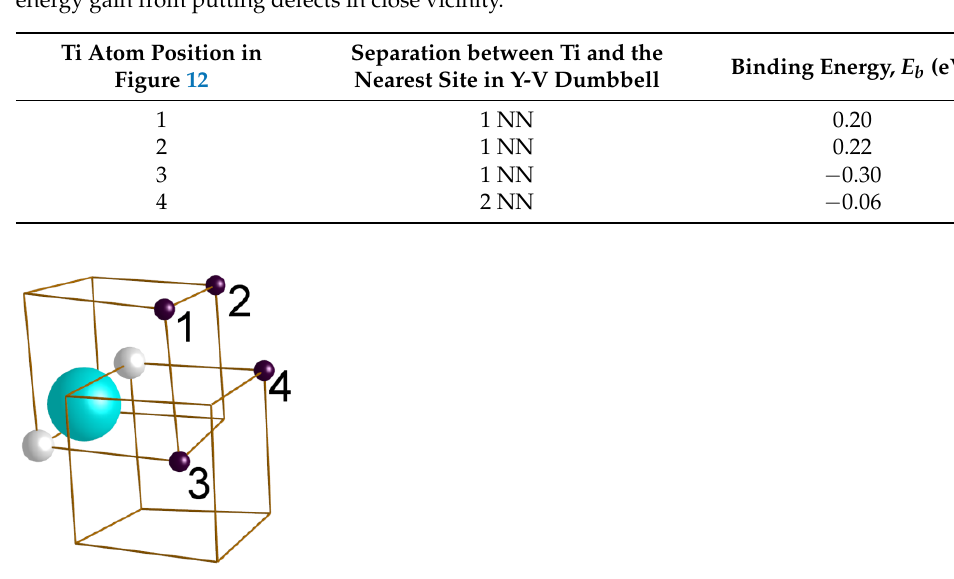
Table 2. The calculated binding energies between Y-V pair and Ti atoms in different configurations, as indicated in Figure 12. Density functional theory-based calculations performed on 128-atomic bcc iron lattice with VASP code [59] using PAW-PBE pseudopotentials [60] with an energy cut-off of 450 eV and a 4 × 4 × 4 Monkhorst–Pack k -point grid [61]. Positive sign of binding energy means energy gain from putting defects in close vicinity.